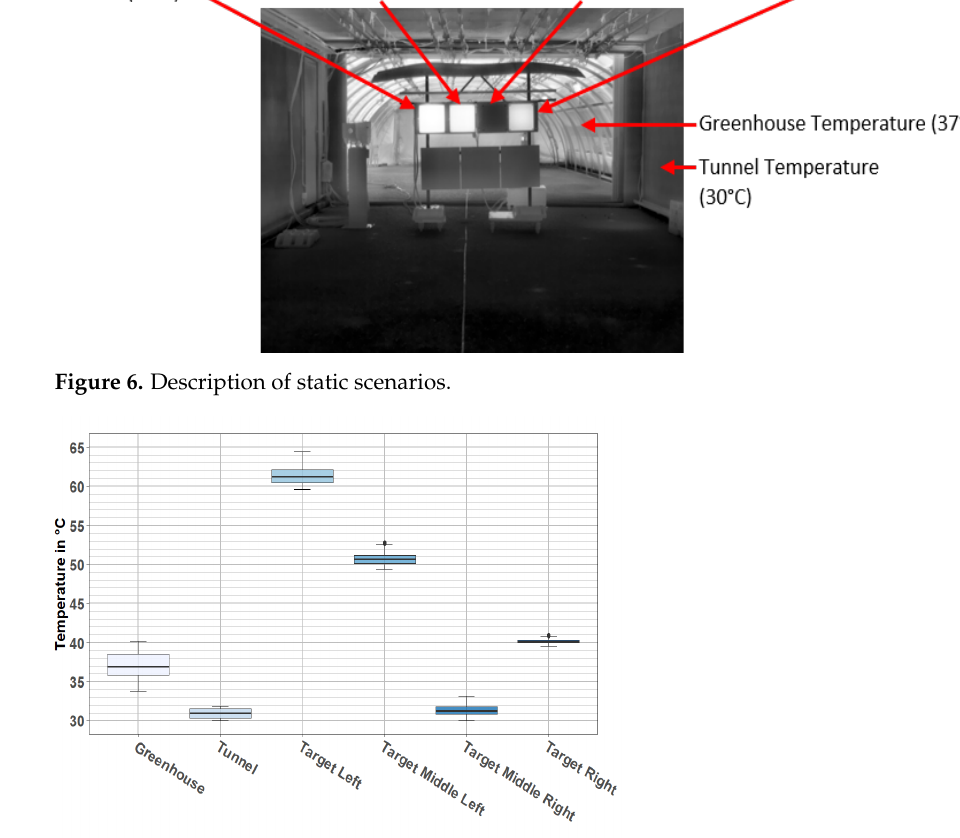
Figure 7. Boxplot of targets’ and rooms’ temperatures during static